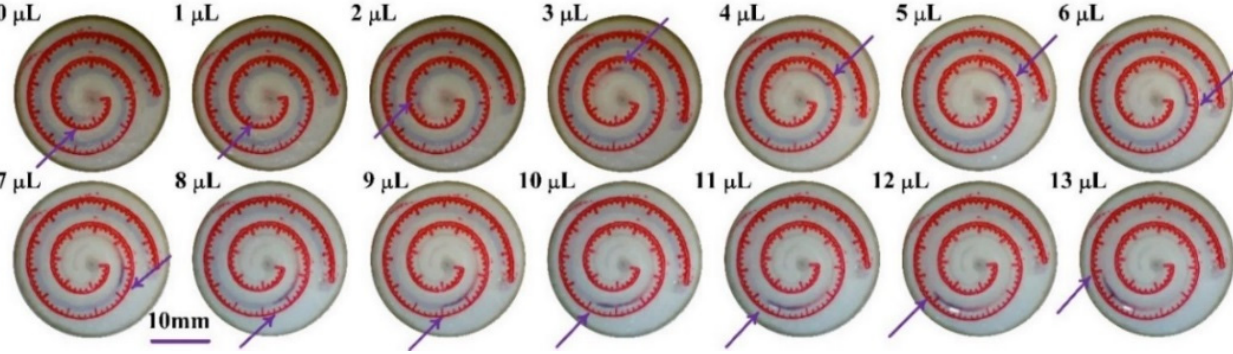
Figure 9. Calibration of a P-SRMC.